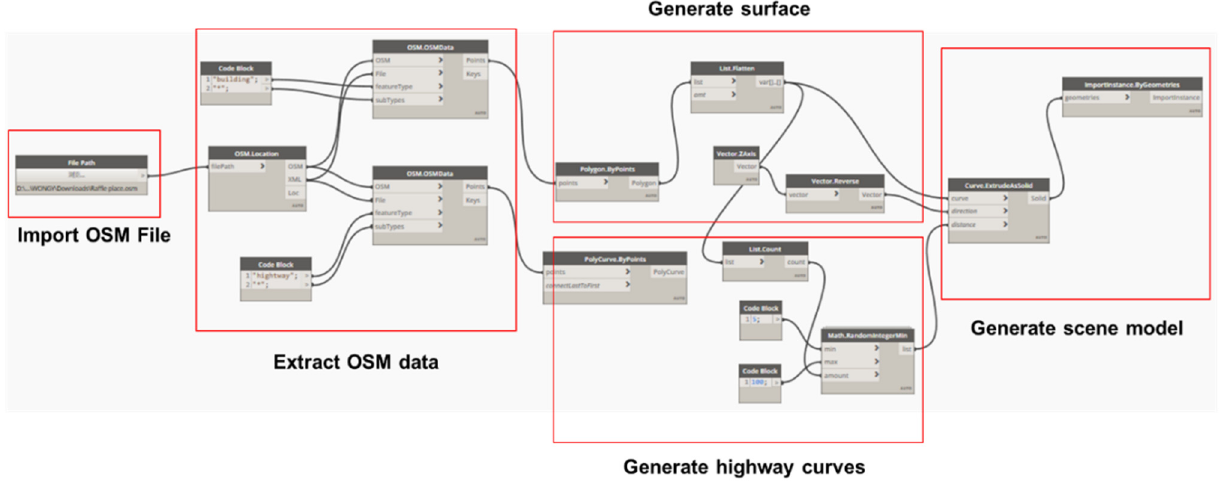
Figure 12. Screenshot of the visual script for generating BIM scenarios.